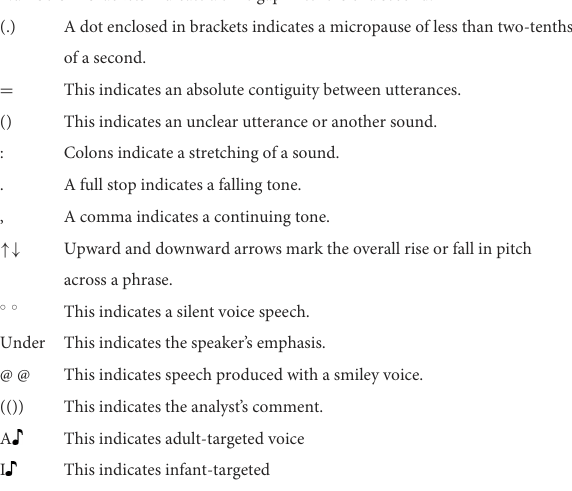
Table A1 The transcription conventions used in the